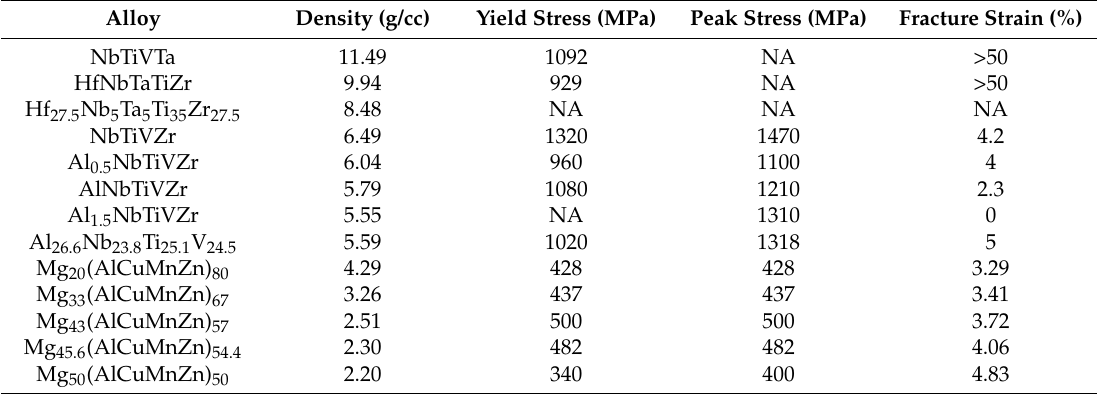
Table 4. List of compression yield stress, peak stress and fracture strain values for different HEAs. Alloy Density (g/cc) Yield Stress (MPa) Peak Stress (MPa) Fracture Strain (%) NbTiVTa 11.49 1092 NA